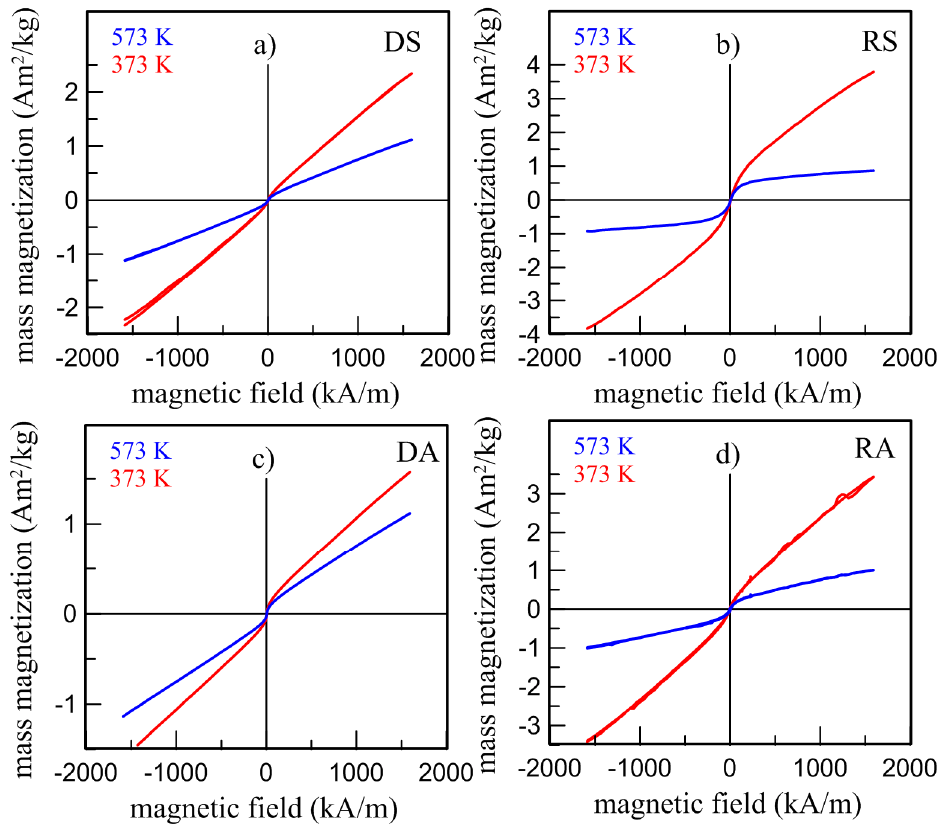
Figure 7. Hysteresis loops of Fe 2 MnSi ( a , DS; b , RS: top panels) and Fe 2 MnAl ( c , DA; d , RA: bottom panels) alloys measured at elevated temperatures T = 373 K, 573 K.